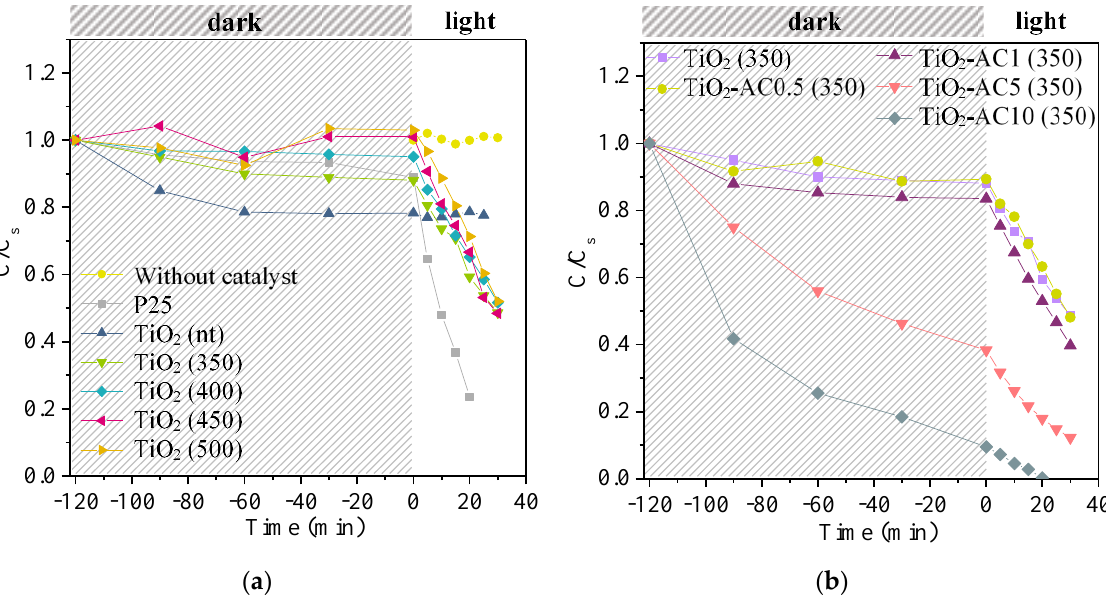
Figure 4. Evolution of the relative concentration of diuron vs. time in the darkness and under illumination using ( a ) P25, TiO 2 (nt) and TiO 2 (T) photocatalysts and ( b ) TiO 2 -ACx (350) (x = 0, 0.5, 1, 5, and 10 wt.%) photocatalysts. The first 120 min (negative numbers in x-axis), correspond to dark conditions and, from the time identified as 0, the system is irradiated.